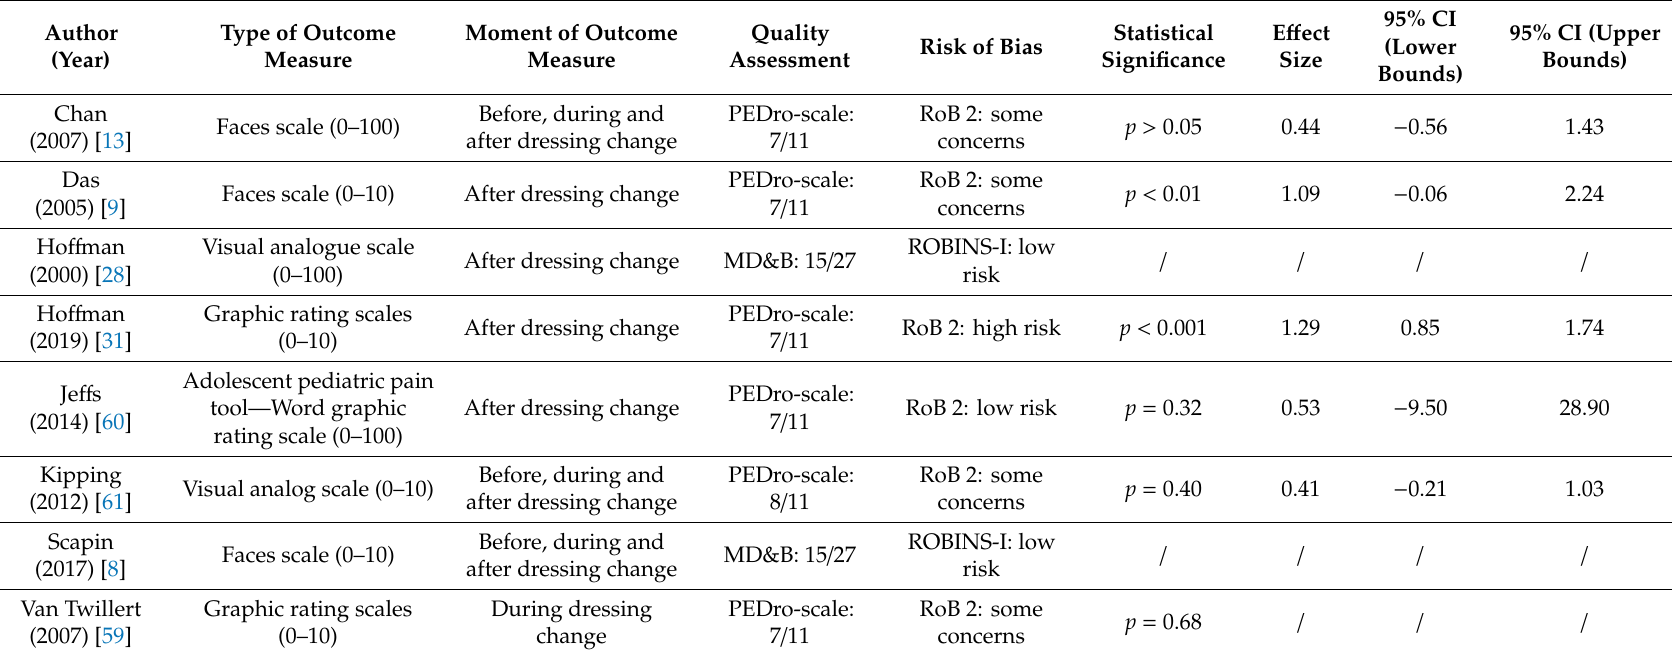
Table A4. Summary of findings for the included studies